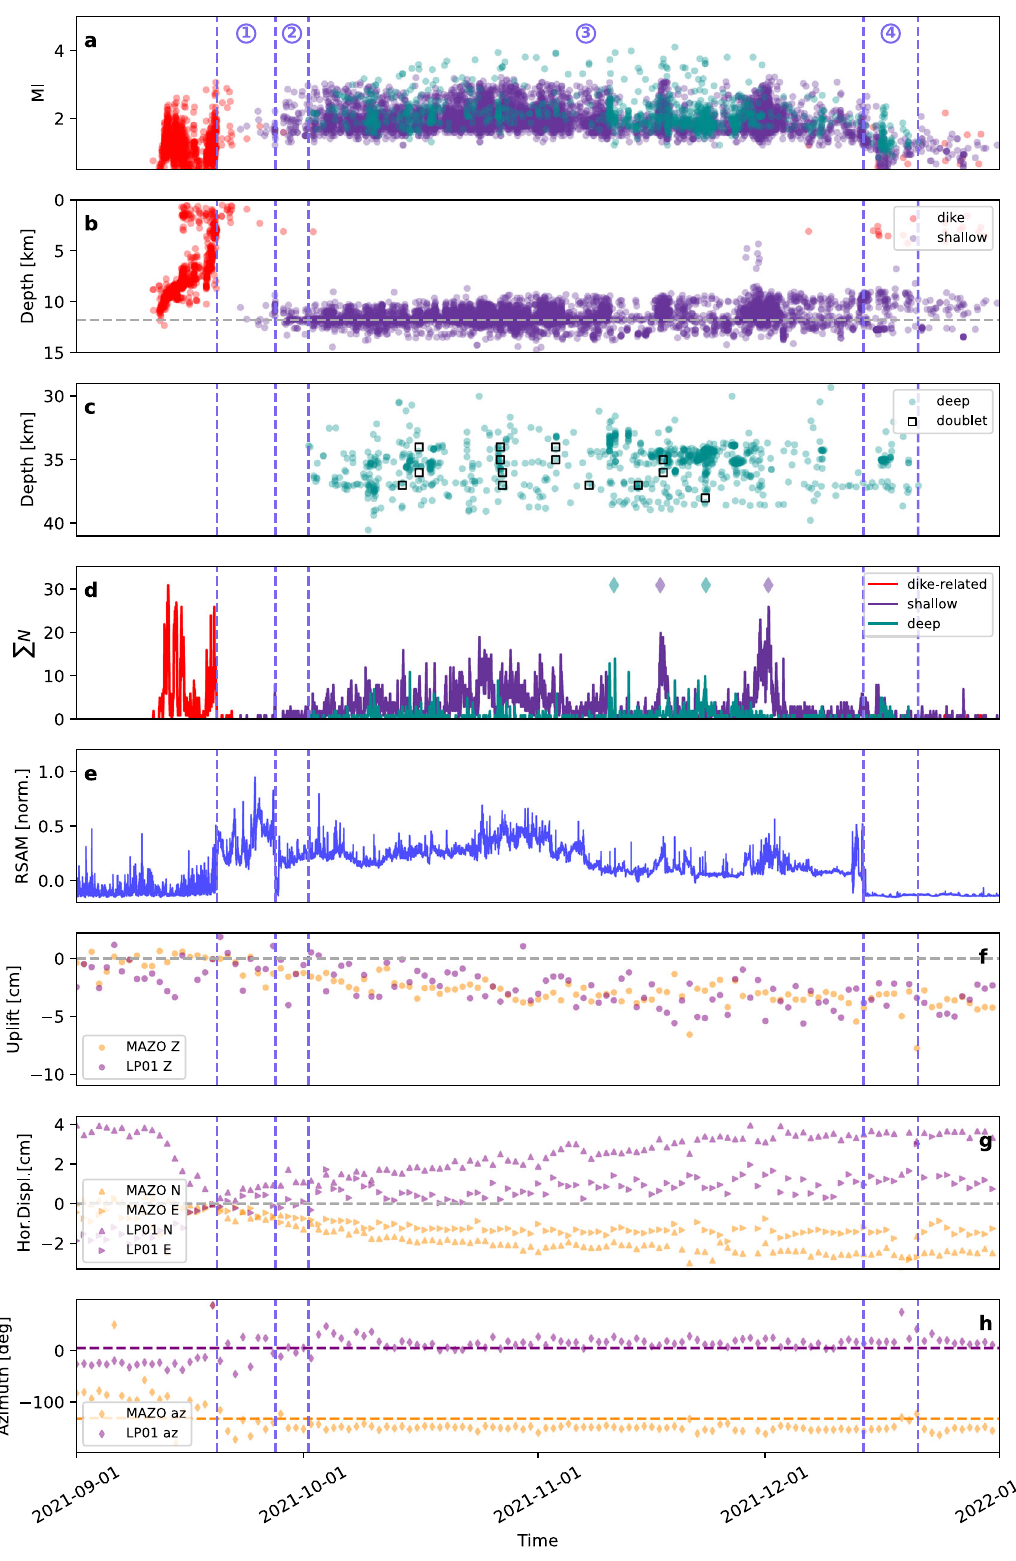
Fig. 3 | Eruption chronology. Plots showthe temporalevolution of: a earthquake magnitudes (red, dark violetand greencirclescorrespond to dike-related,shallow clusteranddeepclusterseismicity,respectively,afterrelocation). b,c Hypocentral depths for the different types of seismicity: dike-related shallow events, earth- quakesattheshallowanddeepcluster,anddeepdoublets. d Dailyseismicityrates (dark violet and green diamonds mark temporary increases in the rate of shallow and deep events, respectively). e Normalised Real-time Seismic Amplitude